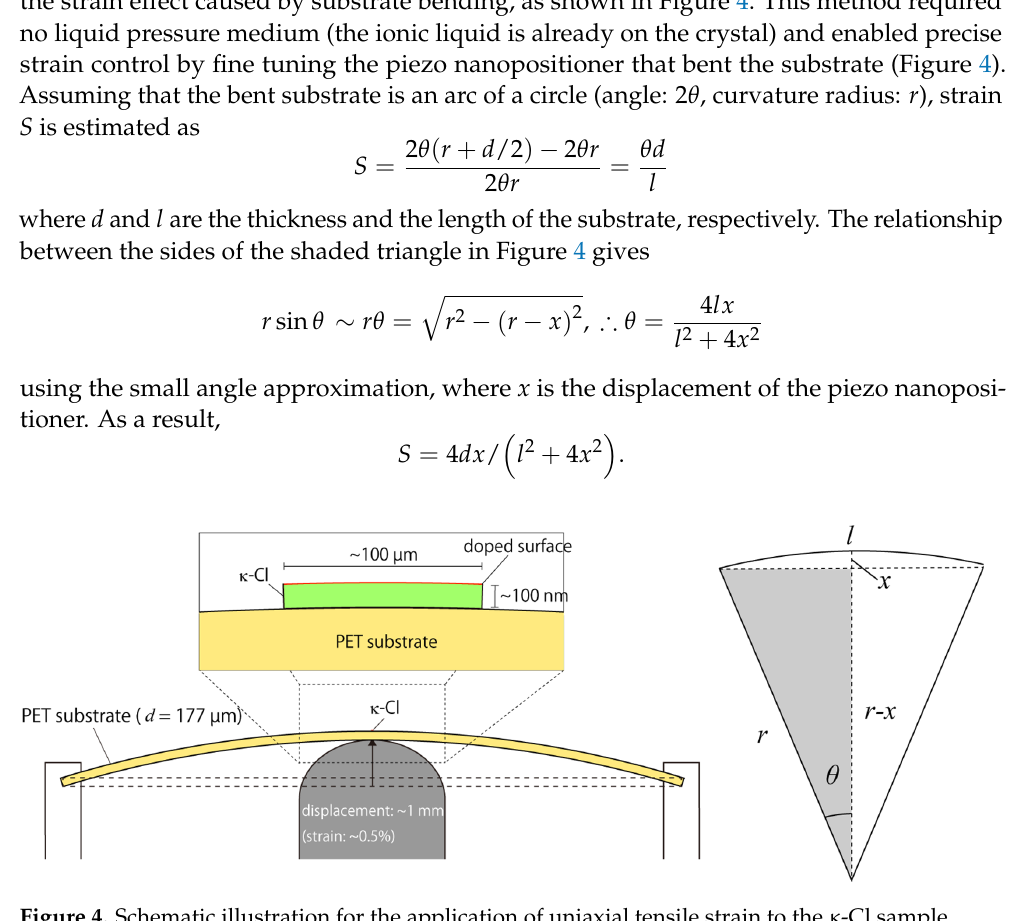
Figure 4. Schematic illustration for the application of uniaxial tensile strain to the κ -Cl